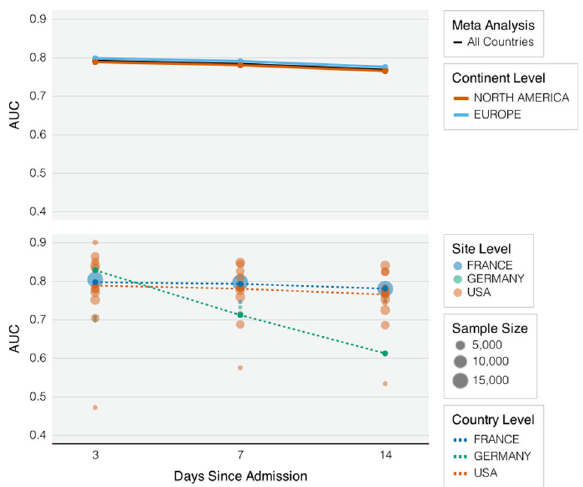
Fig. 2 Risk Model Performance Across Countries and Continents. AUCs of cox regression models with nine common laboratory tests (missing rate <30%) in predicting death adjusting for demographic variables and Charlson comorbidity